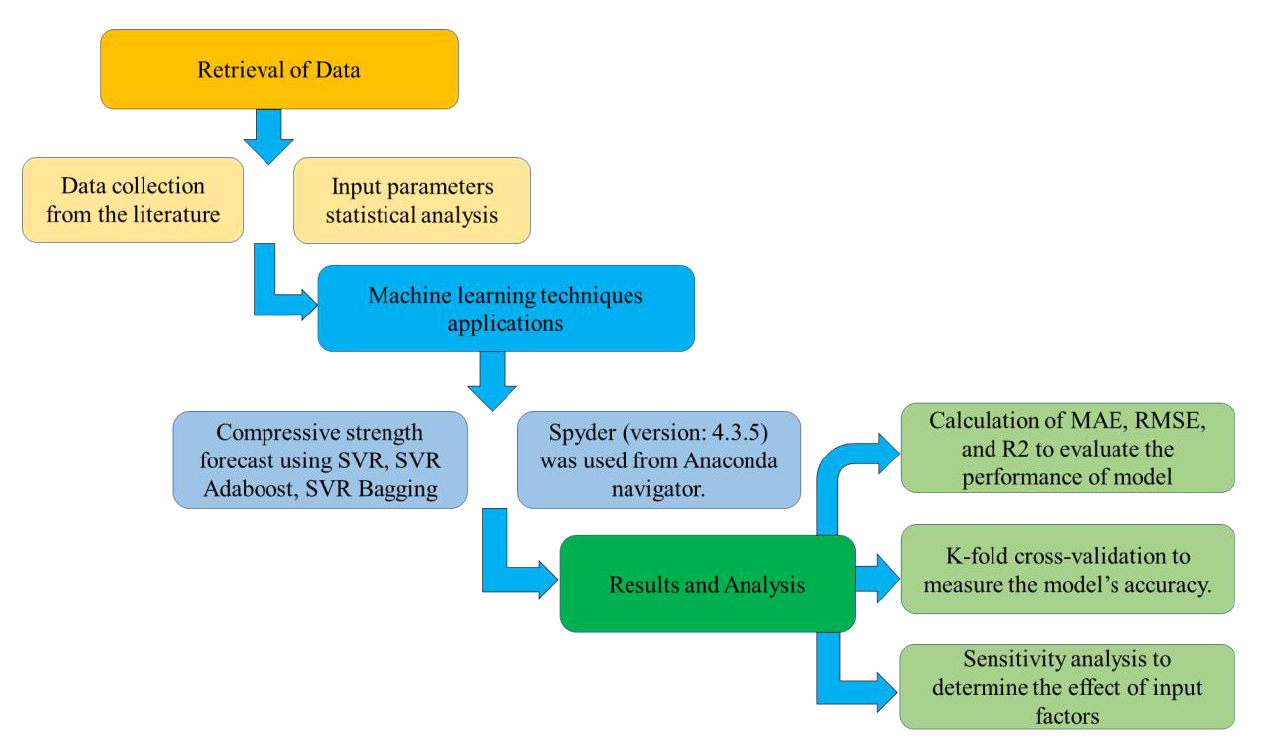
Figure 2. Research methodology in the current study.